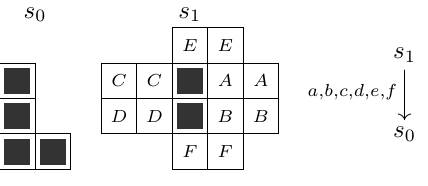
Figure 16: A proof sequence of the maker strategy for (2 , 5) -achieving P 4 , 2 .